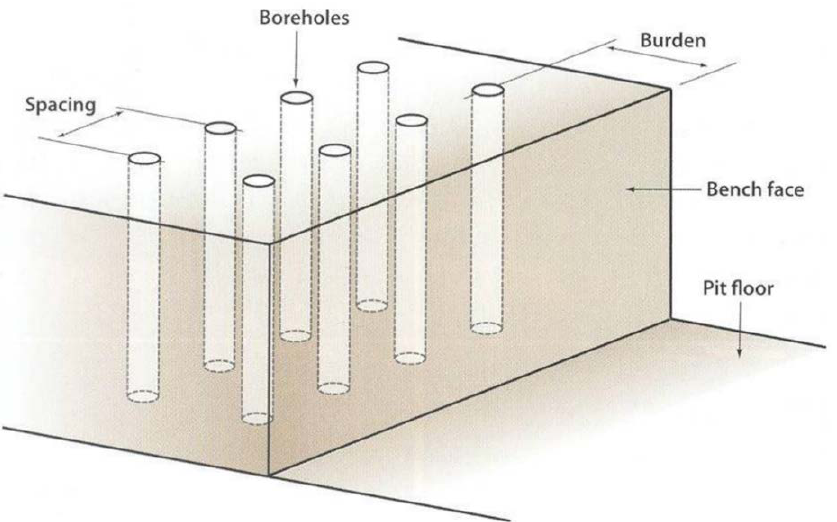
Figure 4. Example of a blasting pattern with indication of the main parameters involved. In partic- ular, the representation of the terms E c and V c (referring to Tables 1 and 2) should be noted [5].